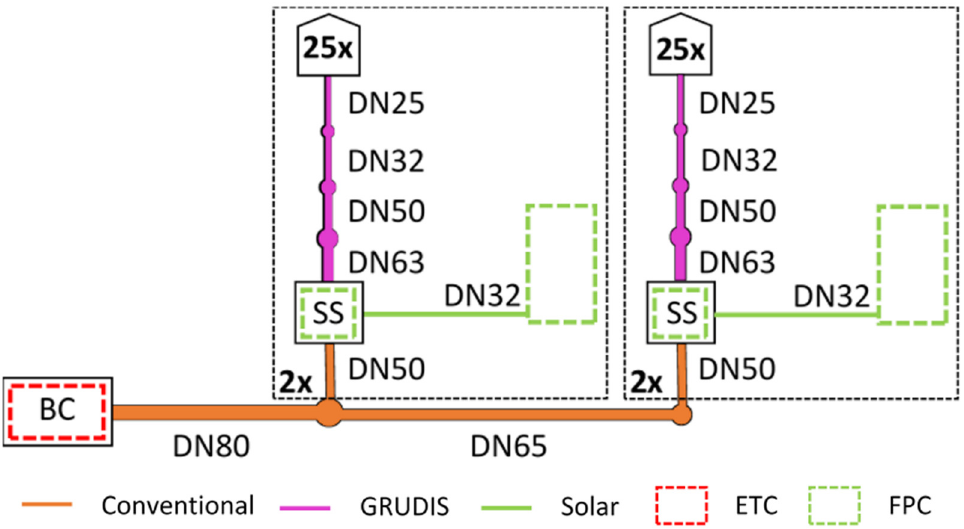
Figure 6. Simplified approach—Schematic showing the hybrid system simulation model and applied pipe sizes. Copper pipes in the solar thermal system are not shown. Scaling factors (2x and 25x) are shown in the substation models where these are used [12]. BC = Boiler central. SS = substation.